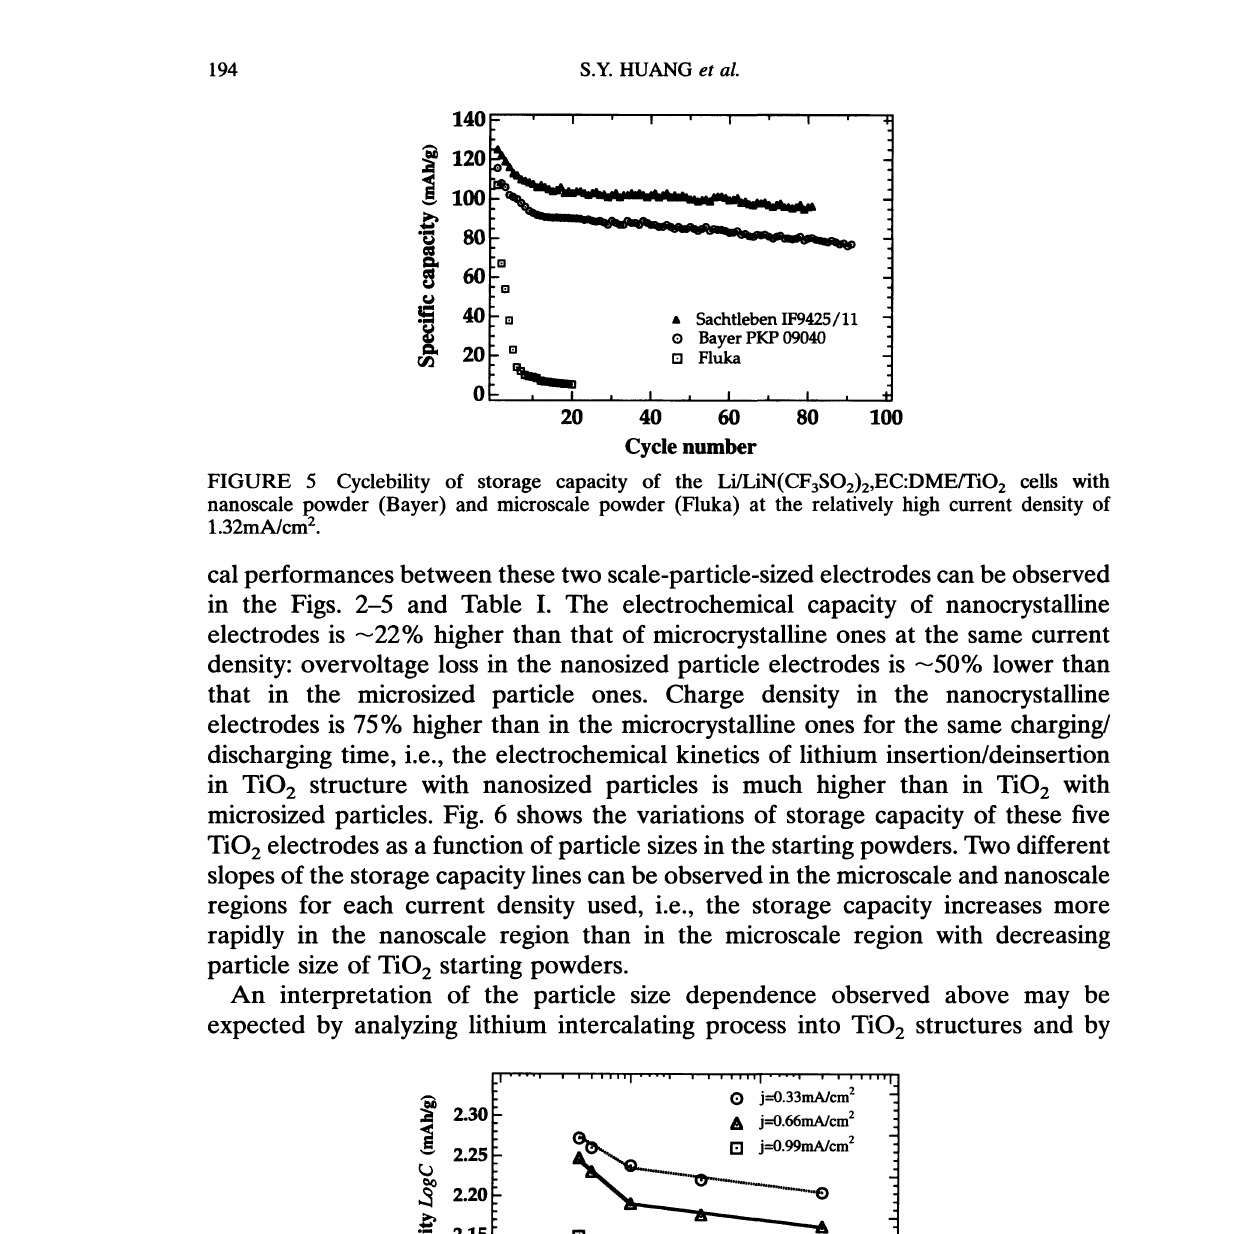
FIGURE 6 Variation of storage capacity with particle size of the Li/LiN(CF3SO2)2, EC:DME/TiO2